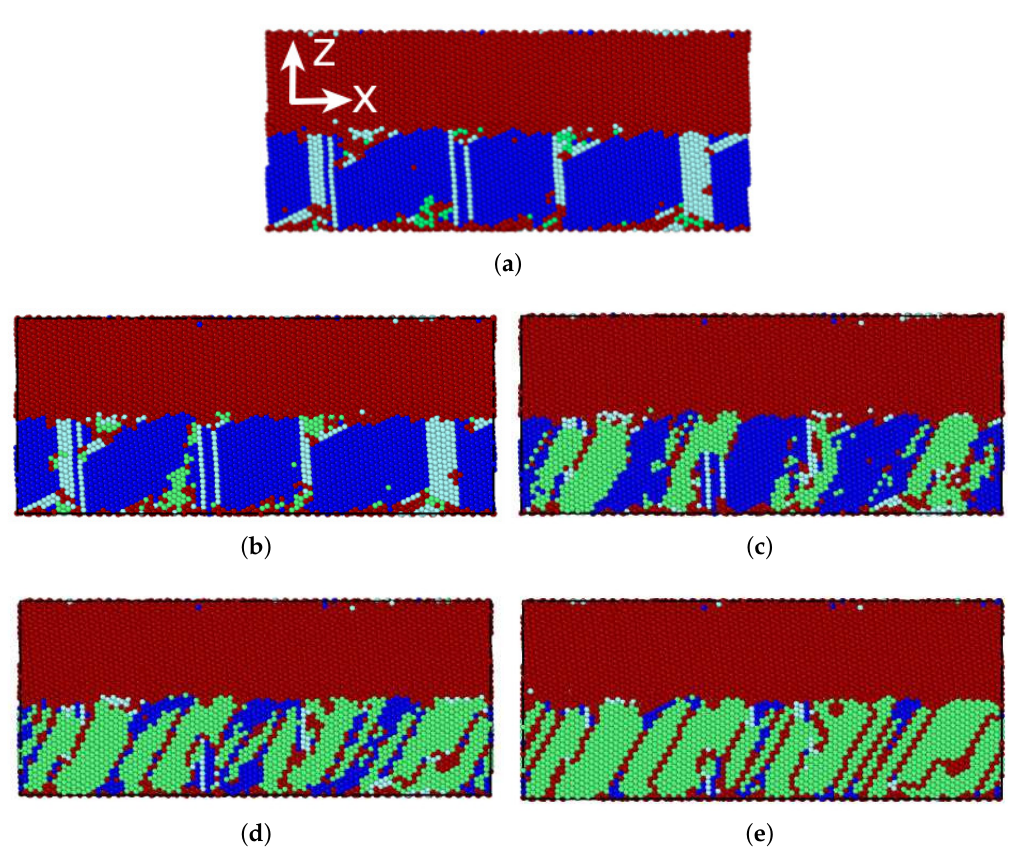
Figure 8. Cross-sectional views (in the z – x plane) of the transforming system during the martensitic transformation at: 400 K ( a ); 328 K ( b ); 288 K ( c ); 208 K ( d ); and 4 K ( e ). Atoms are colored as in Figure 2; in particular, the cementite crystallite is